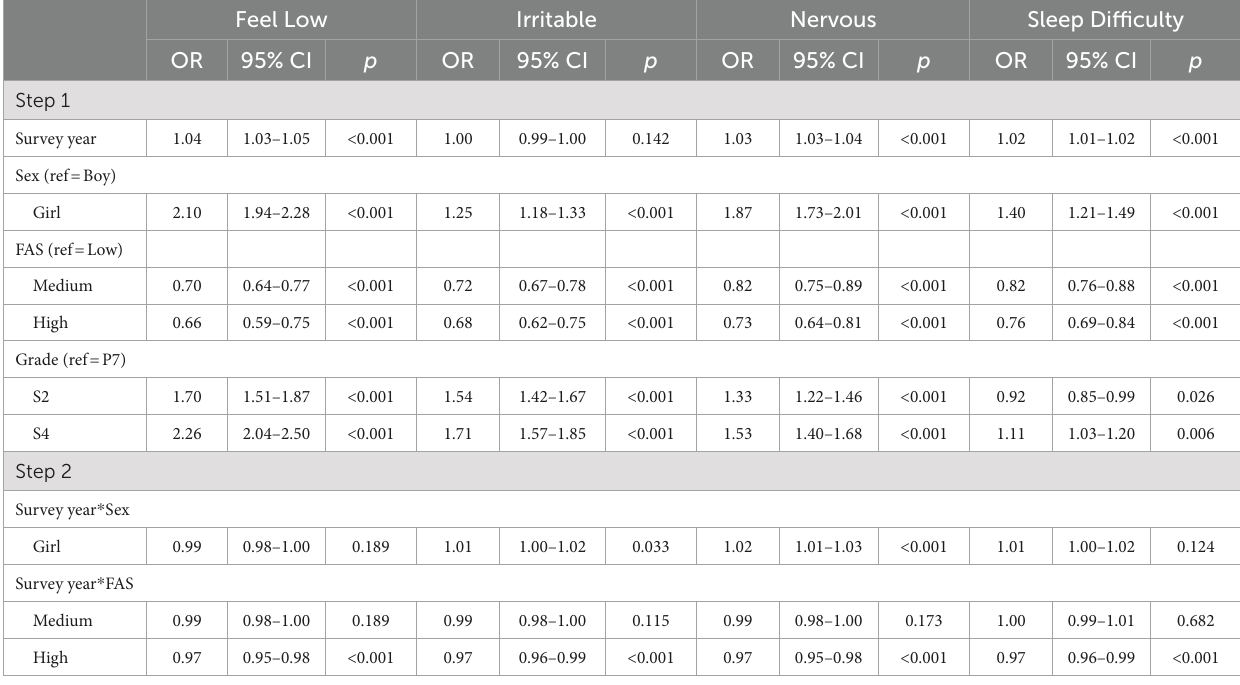
TABLE 3 Odds ratios of reporting weekly psychological symptoms. Feel Low Irritable Nervous Sleep